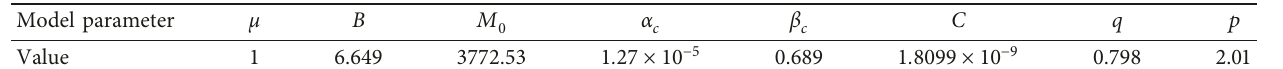
Figure 12: The relationship between the cyclic block, the analysis step, and the number of cyclic loads. Table 1: Parameter values in the CF damage model.